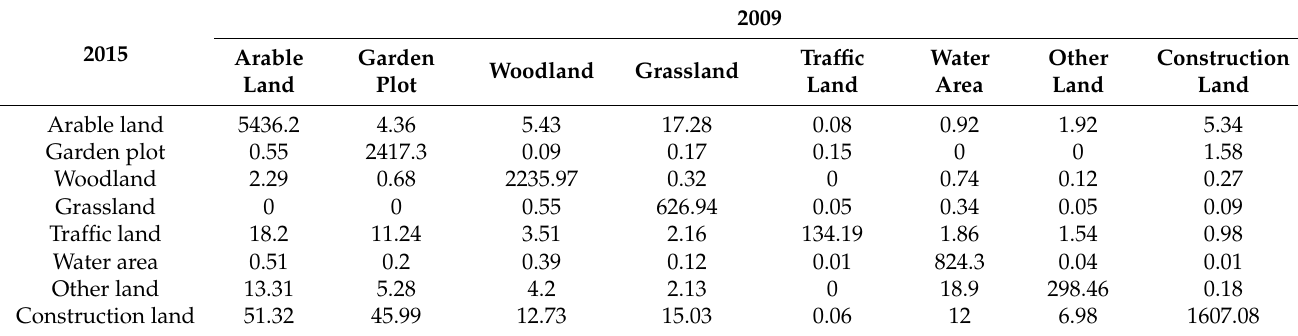
Table 5. The land-use transfer matrix 1 of Yantai from 2009 to 2015 (km 2 ).